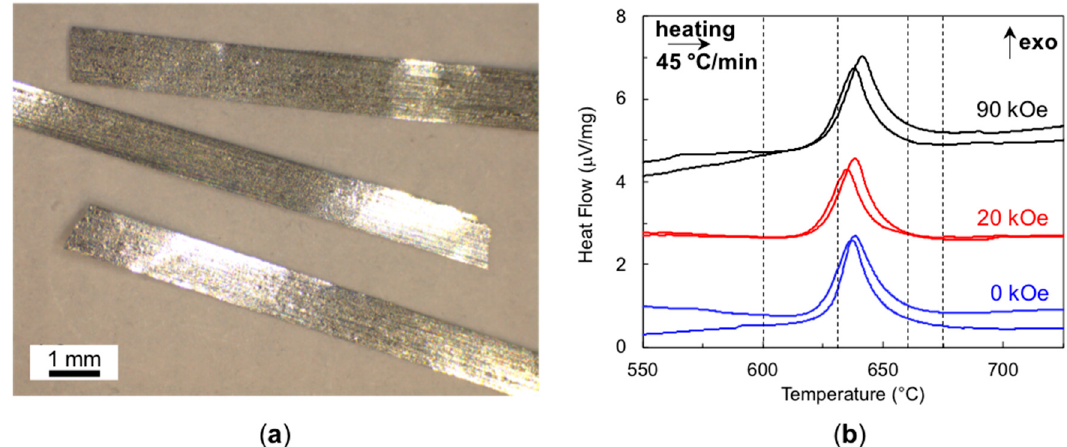
Figure 1. ( a ) Optical micrograph of the ‘wheel side’ of the Nd 2 Fe 14 B + TiC melt-spun ribbons and ( b ) DSC curves showing the exothermic peak during crystallization of the Nd 2 Fe 14 B as-spun ribbons at zero-field (blue) and applied fields of 20 kOe (red) and 90 kOe (black). Data are shown for two different samples for each field. Dashed vertical lines indicate the temperatures chosen for the heat treatments.